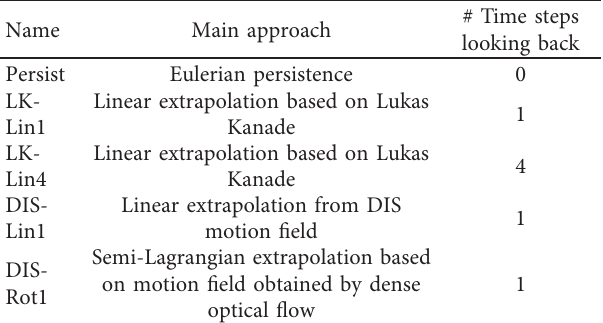
Table 2: Overview of extrapolation